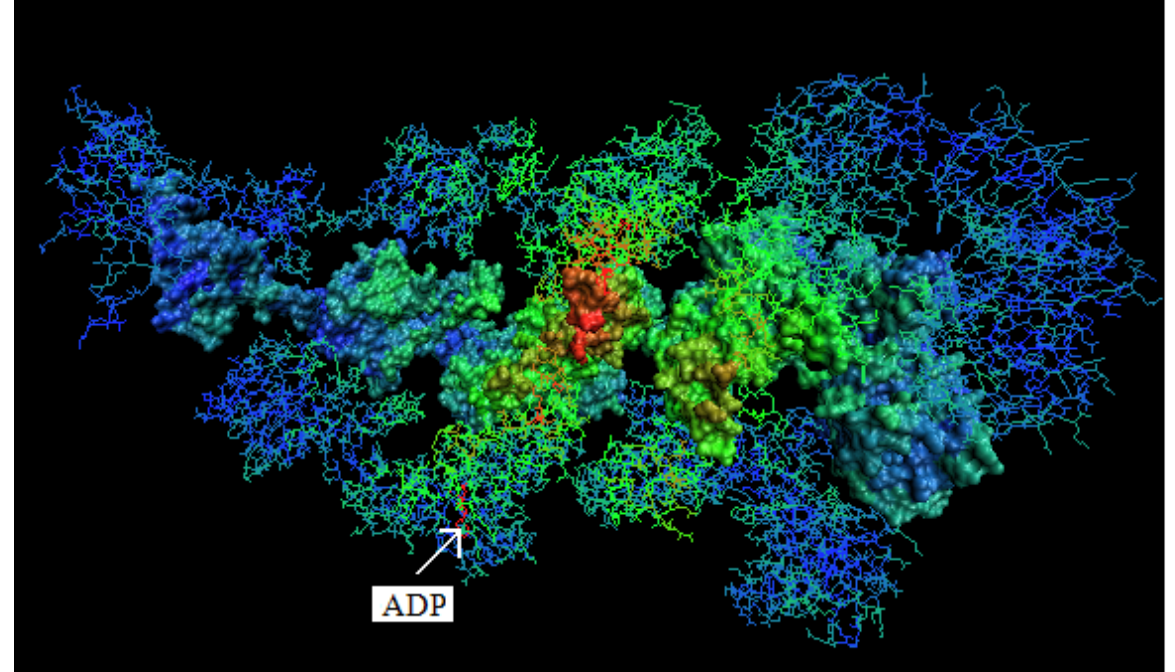
Figure 8. The O-A-H chain system (space filling presentation) in the company of two neighbors chains (T+P, B+G, I+N) in lines presentation. The color scale expresses the ~ ~ ~ H Δ magnitude (the higher H Δ the more red color, the lower H Δ the more blue color). The green color represents the area of hydrophobicity accordant with the idealized ‘fuzzy oil drop” model. The molecule shown in red – the ADP molecule complexed to the